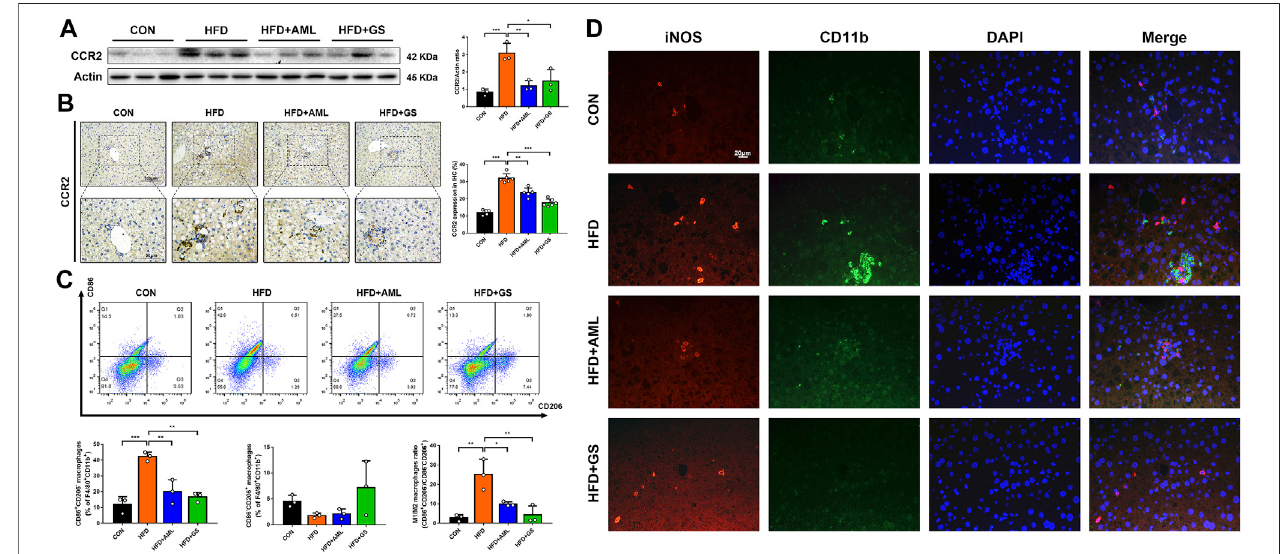
FIGURE 4 | GS inhibited pro-in fl ammatory macrophage recruitment. (A) Western blot analysis of CCR2 in liver tissues and statistical graph, n (cid:1) 3. (B) Immunohistochemical staining of CCR and statistical graph, n (cid:1) 4 – 6. (C) The phenotype of macrophages in liver tissues was measured by fl ow cytometry, n (cid:1) 3. F4/ 80 + CD11b + waslabeledtorepresentthemacrophages,whileCD86 + CD206 - macrophageswererecognizedasM1phenotype,andCD86 − CD206 + macrophageswere recognized as M2 phenotype. (D) Double immuno- fl uorescence staining of iNOS and CD11b. Results are presented as means ± SD. *p < 0.05, **p < 0.01, ***p < 0.001 .